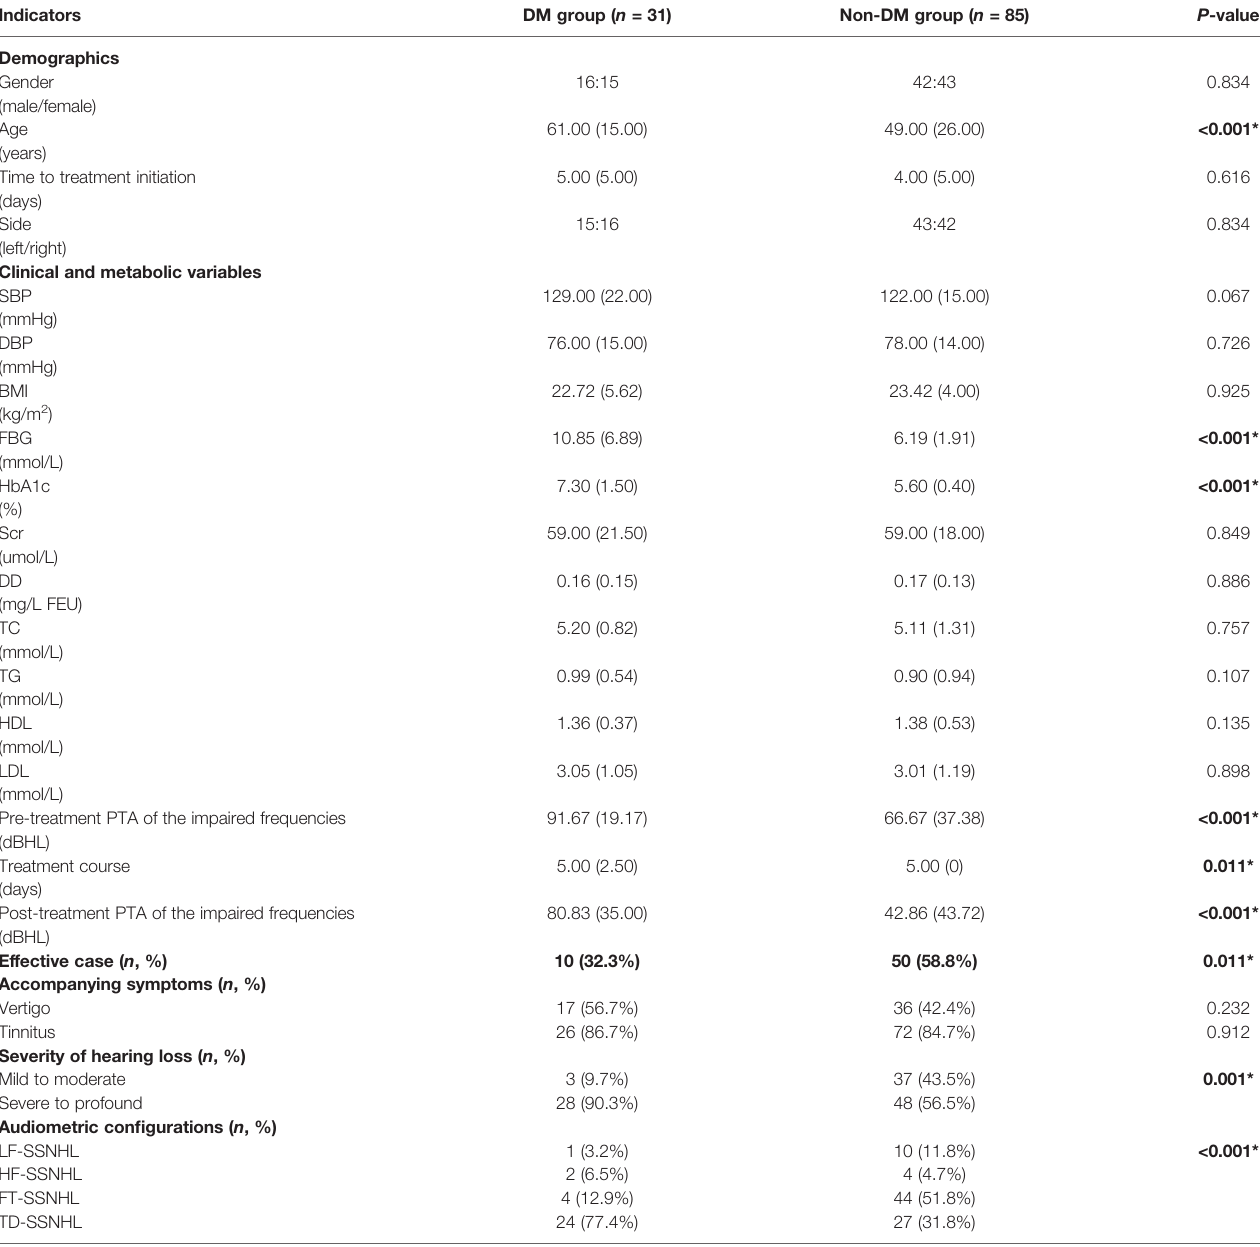
TABLE 1 | Clinical characteristics of study participants before propensity score